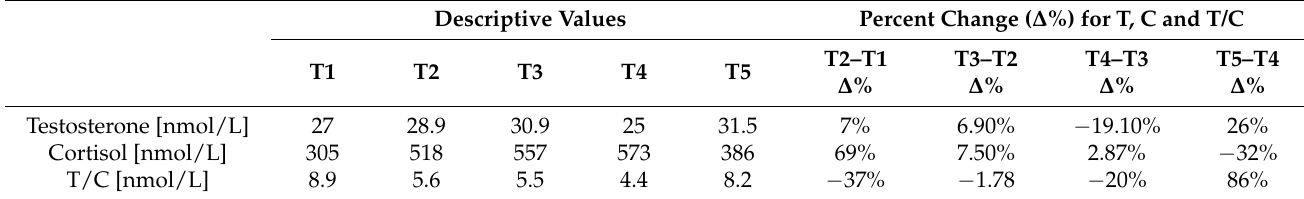
Table 6. Anabolic-to-catabolic hormone alterations over the 16 weeks. Descriptive Values